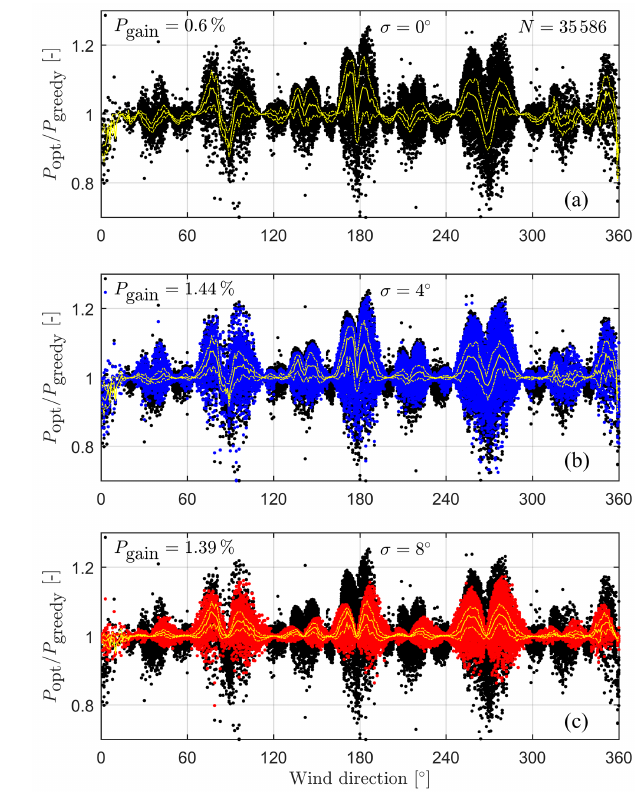
Figure 11. Test case A: evaluation of the relative power gain over the estimated wind direction ϕ est from the measured time series of 5min averaged wind direction during approx. 5 months. The yel- low plot marks the median of the power gain for the respective wind direction and the dashed yellow plot above and below the me- dian are the upper and lower quartiles, respectively. (a) Conven- tional wake deflection (black), (b) and (c) robust wake deflection for σ = 4 (blue) and σ = 8 ◦ (red), respectively.